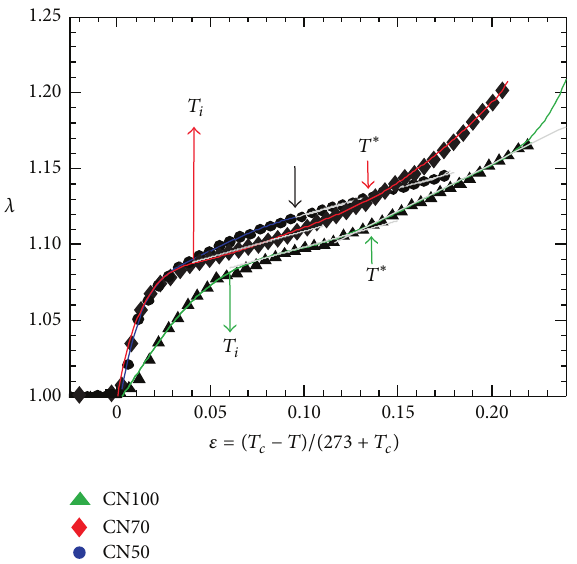
Figure 4: Length change data, 𝜆 , for 󳵳 CN100, X CN70, and ∙ CN50 versus 𝜀 , with 𝑇 𝑐 = 94.2 ∘ C (CN50); 110.6 ∘ C (CN70), and 112.6 ∘ C (CN100) plotted as symbols. The 𝜀 ≥ 0 ( 𝑇 ≲ 𝑇 𝑐 ) solid curves superposing that the data are 6th-order polynomial fits. To compare with the phase plot in Figure 3, arrows show that 𝑇 ∗ = 60 ∘ C for the three CN compositions and 𝑇 𝑖 for CN70 ( 95 ∘ C) and CN100 ( 90 ∘ C). For CN50, 𝑇 𝑖 ∼ 𝑇 𝑐 . Data for 𝑇 > 𝑇 ∗ is linear for CN100 up to 𝜀 ∼ 0.2 and nonlinear for CN70 (see text for